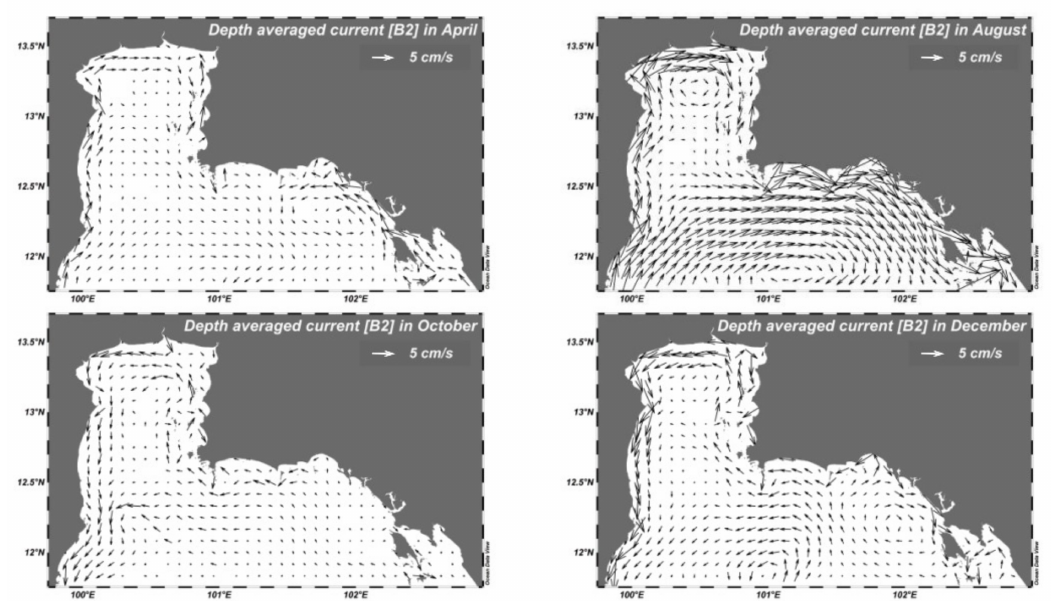
Figure 2. Average current flow by monthly representing the different seasons in the northern Gulf of Thailand (arrows denote the direction and speed of the currents) (Tong-u-dom, et al. 2017) [37].